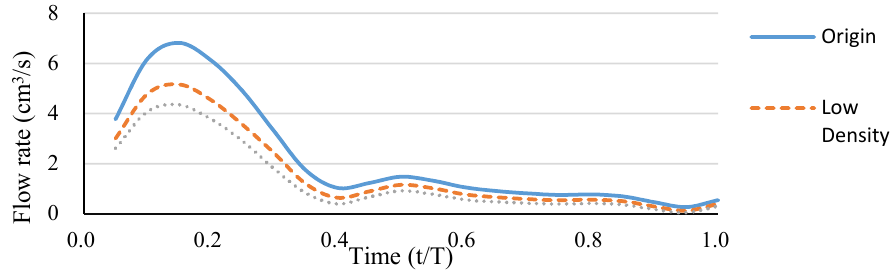
Figure 11. Blood flow rate reduction as a function of time in a single pulse in the right hepatic artery.